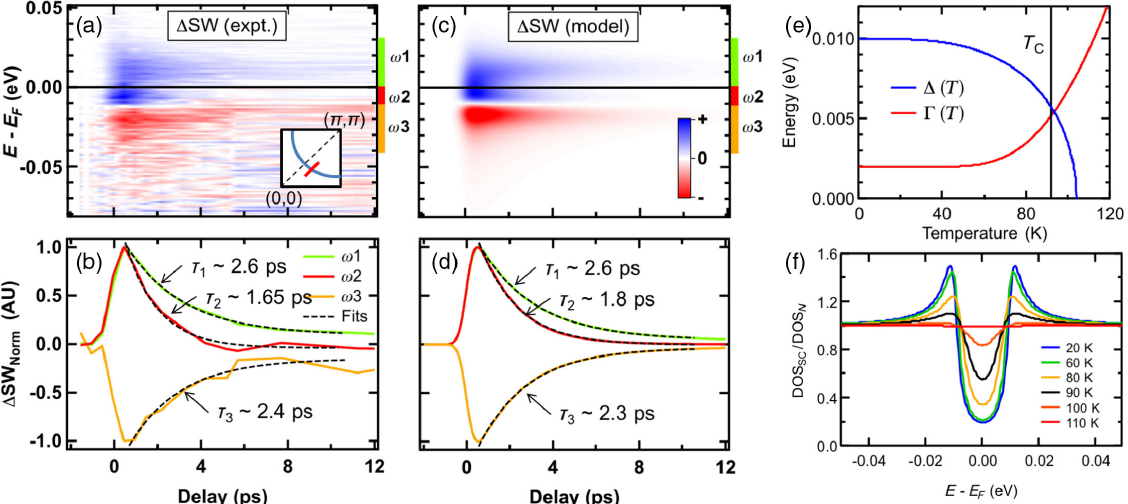
FIG. 4. Ultrafast off-nodal gap and quasiparticle response — data and thermal model. Panel (a) shows the Δ SW map for the cut shown in the inset. Temporal line cuts for different energy regions are shown in panel (b) along with single exponential fits and their returned lifetimes. The energy regions, chosen to improve the counting statistics while still separating the qualitatively different spectral regions, are defined as − 40 meV < ω 3 < − 12 meV, − 12 meV < ω 2 < 0 meV, and 0 meV < ω 1 < 30 meV. For clarity, we normalize the temporal line cuts to their maximum values. Panel (c) shows a simulated Δ SW map using our zero-parameter thermal model, discussed in the text. This model, with no free parameters, captures both the qualitative and quantitative features of the experimental data, as shown by the model line cuts in panel (d) (integrated over the same ω ranges) and their associated fitted lifetimes, which match the experimental data well. Panel (e) shows the gap and pair-breaking rate extracted from high-resolution equilibrium ARPES [40] that serve as the input to the thermal model. Panel (f) shows some representative TDoS curves, simulated from the inputs in (e), for which the key effect is the gap principally filling with increasing T